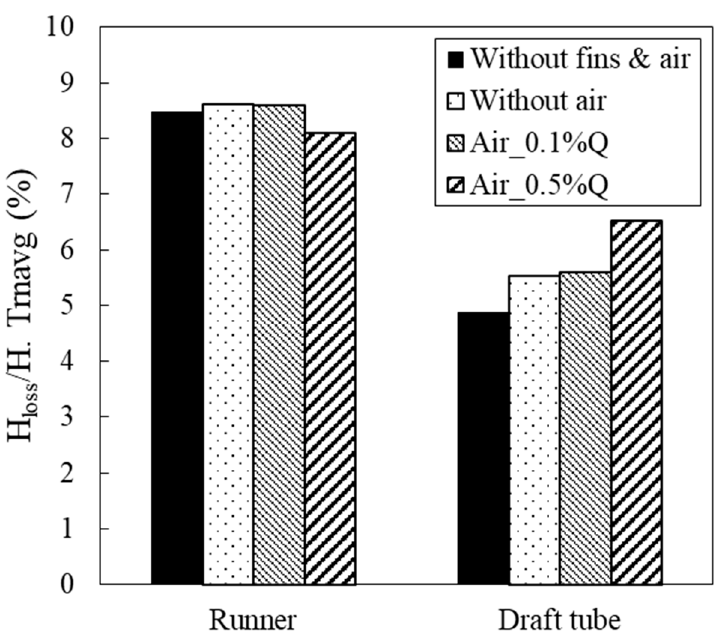
Figure 6. Head loss distribution of the runner and DT associated with the Francis turbine model.